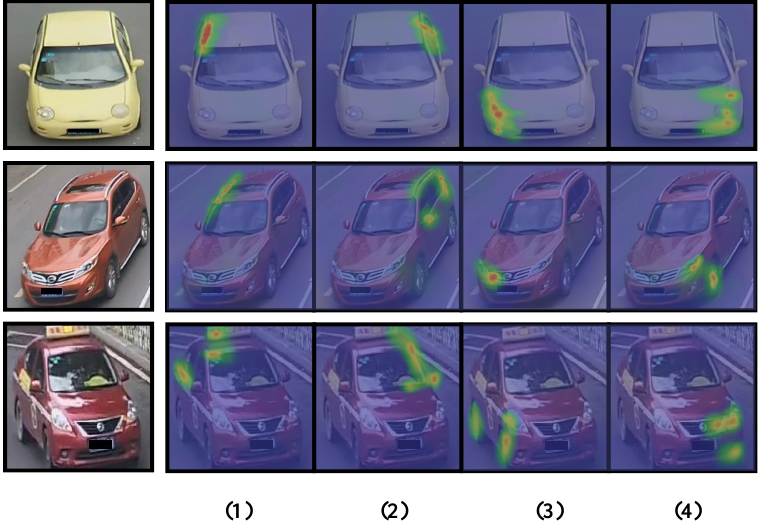
Figure 8. Visualization of results in our proposed APANet. The original vehicle images and their attention maps of N p = 4 local features. Table 5. The impact of the number of MA modules on VeRi-776 [3] dataset. Number of MA Modules Rank-1